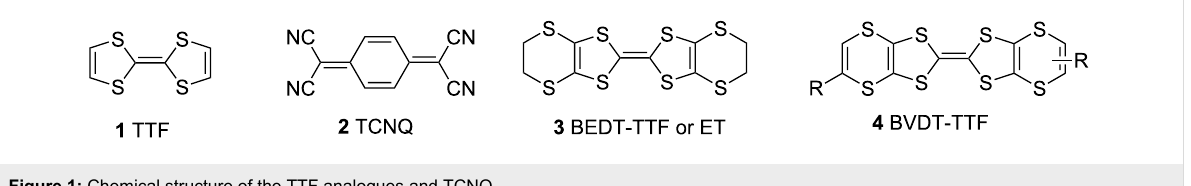
rings [31-34] and the construction of molecules having acceptor substituents [35-37]. Generally, all these modifications